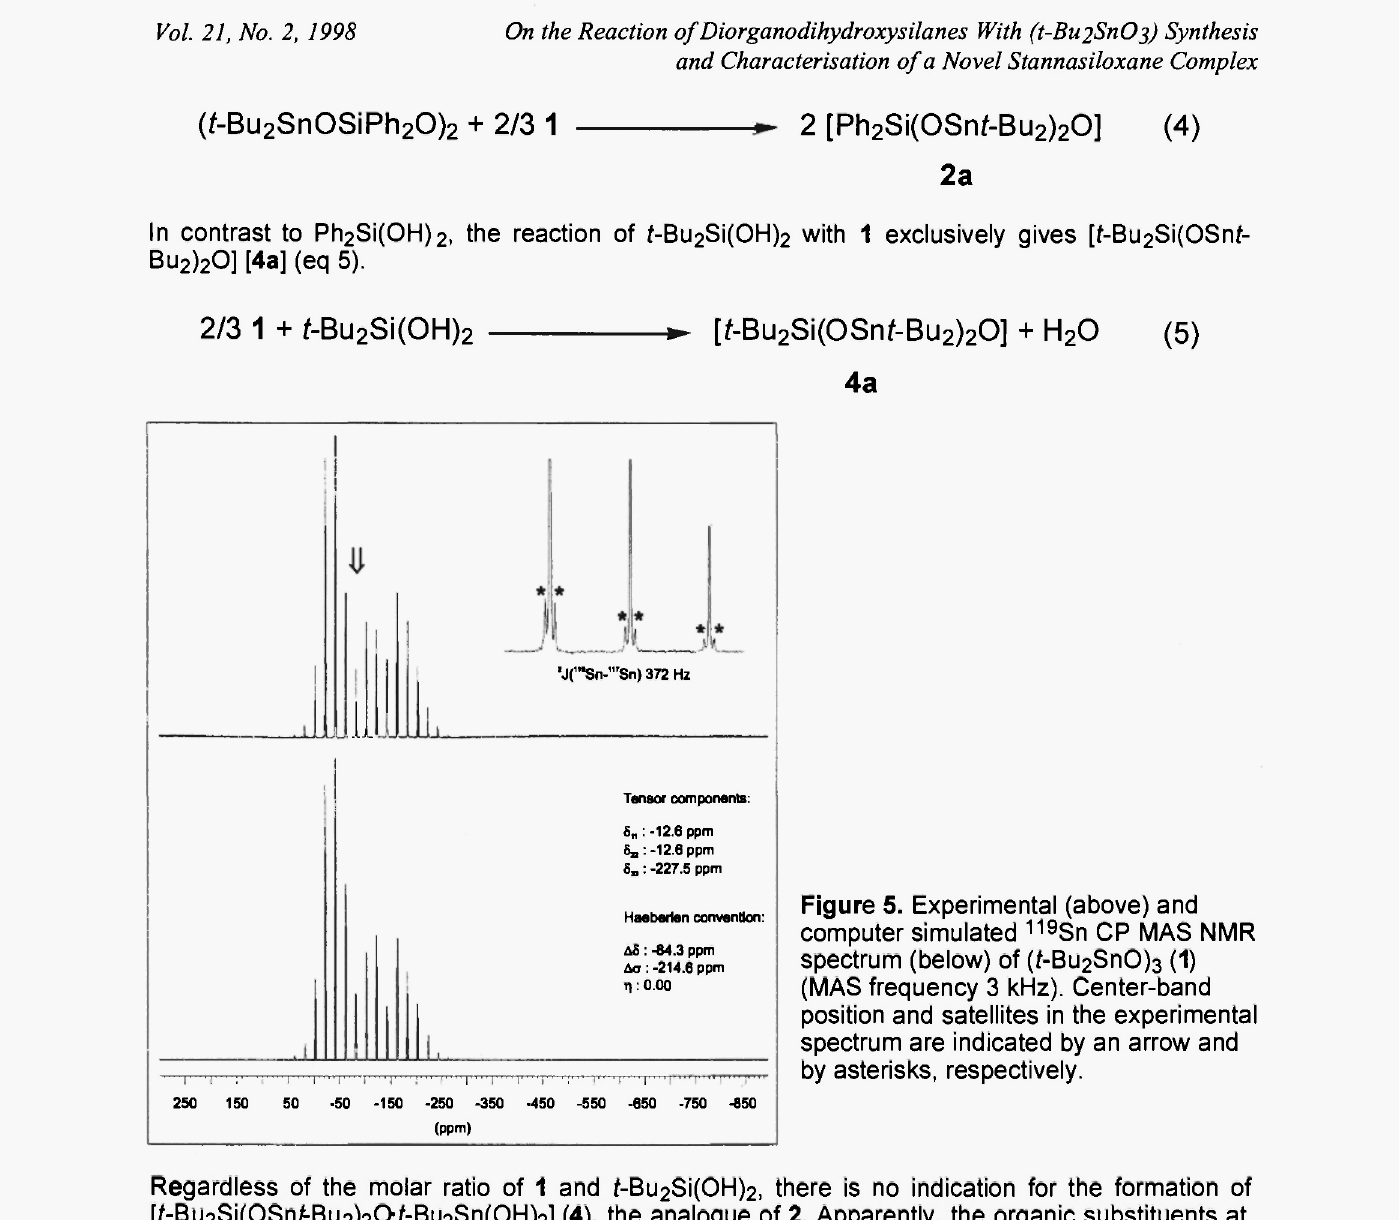
Figure 5. Experimental (above) and computer simulated 119 Sn CP MAS NMR spectrum (below) of (f-Bu 2 SnO) 3 (1) (MAS frequency 3 kHz). Center-band position and satellites in the experimental spectrum are indicated by an arrow and by asterisks,